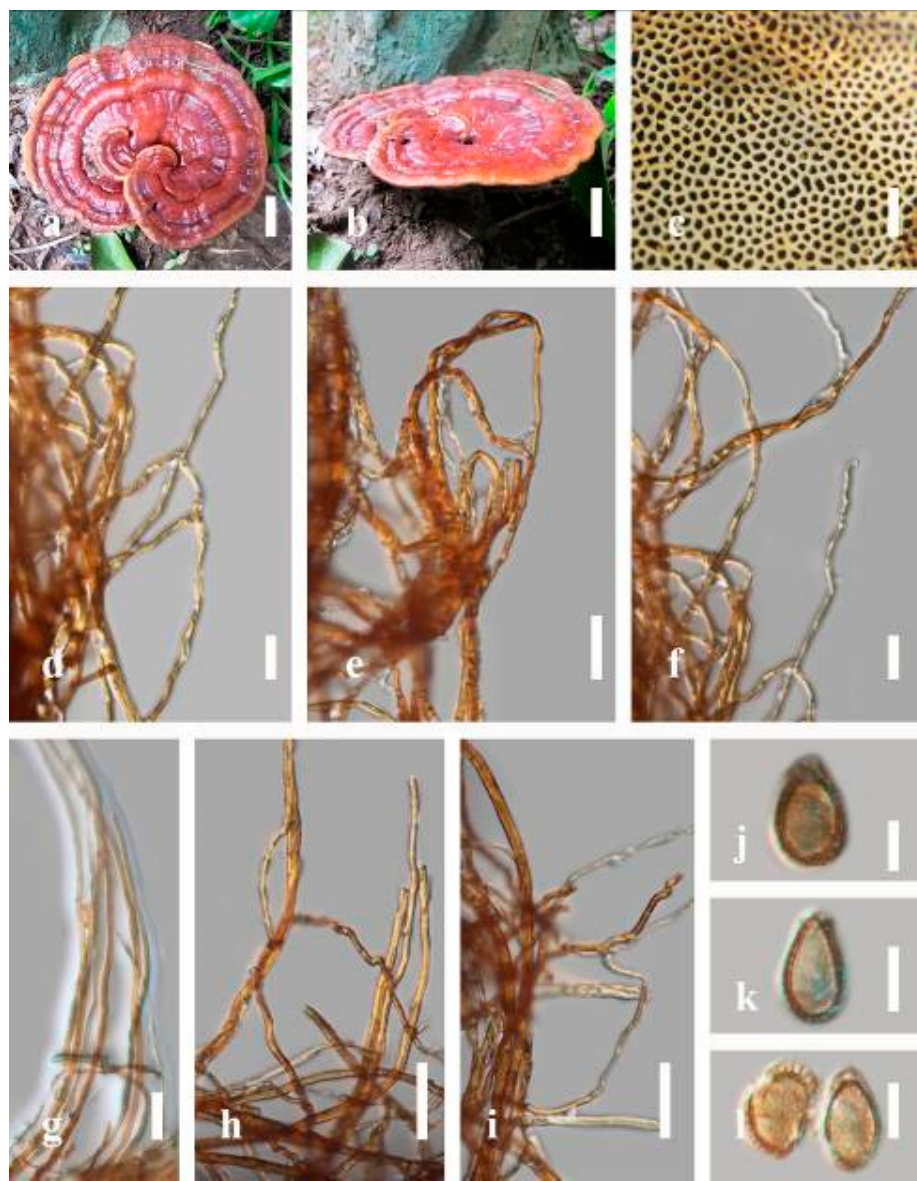
Figure 30. Morphology of Ganoderma sichuanense (MFLU 19 ‐ 2164): ( a , b ) mature basidiomes; ( c ) pore characteristics; ( d – f ) walls varying in thickness sparing branched of generative and skeletal hyphae of context in upper part in Melzer’s reagent; ( g ) generative hyphae of context in lower part in Melzer’s reagent; ( h , i ) thick ‐ walled sparing branched of generative and skeletal hyphae of context in lower part in Melzer’s reagent; ( j – l ) basidiospores in Melzer’s reagent. Scale bars: ( a , b ) = 2 cm, ( c ) = 500 μ m, ( d ) = 50 μ m, ( e , f , h , i ) = 20 μ m, ( g ) = 30 μ m, ( j – l ) = 5 μ m. Ganoderma sinense J.D. Zhao, L.W. Hsu, and X.Q. Zhang, Acta Mycologica Sinica. Hyphal structure : Hyphal system trimitic, with bearing clamp connections, hyaline, 19: 272 (1979) (Figure 31) with walls varying in thickness with simple septa, composed of narrow and sparingly Facesoffungi number: FoF 06253 Description: Basidiomes annual, stipitate, subdimidiate. Pileus 4–10 cm in length, 6–